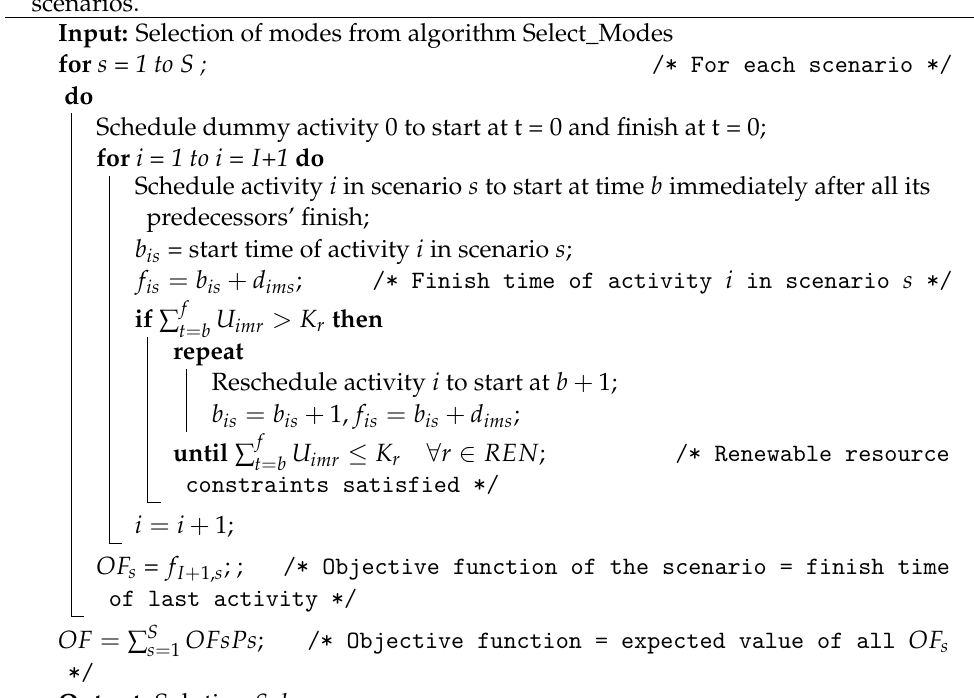
Algorithm 2: Schedule_Scenarios. Algorithm for solution scheduling for the